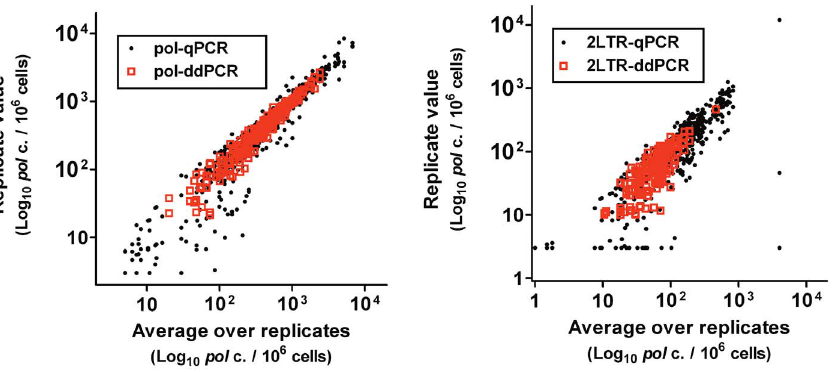
Figure 4. Precision of ddPCR versus qPCR. Samples of DNA ( N =156) isolated from the PBMC of patients during the first 6 months of cART were analyzed by both qPCR and ddPCR in triplicate. The reproducibility was higher for both the pol ( a ) and 2-LTR ( b ) targets. Because the noise and stochasticity of all assays varies with copy number, the relative precision was assessed by averaging the coefficient of variation within small bins (Fig. S2 (b)). The average coefficient of variation was 4-fold lower by ddPCR (Fig. S4 (b)) and 20-fold lower for 2-LTR (Fig. S4 (c)). An imputed value of 6 copies/10 6 cells, equivalent to 1 copy/well, was used for wells in which no template was detected.